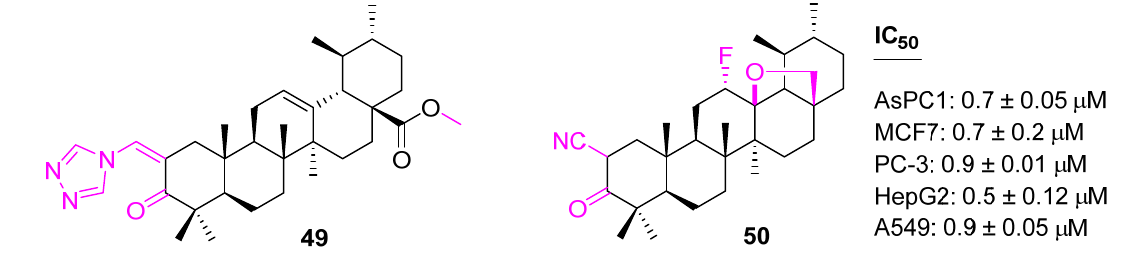
Figure 34. Structure of 49 , 50 .